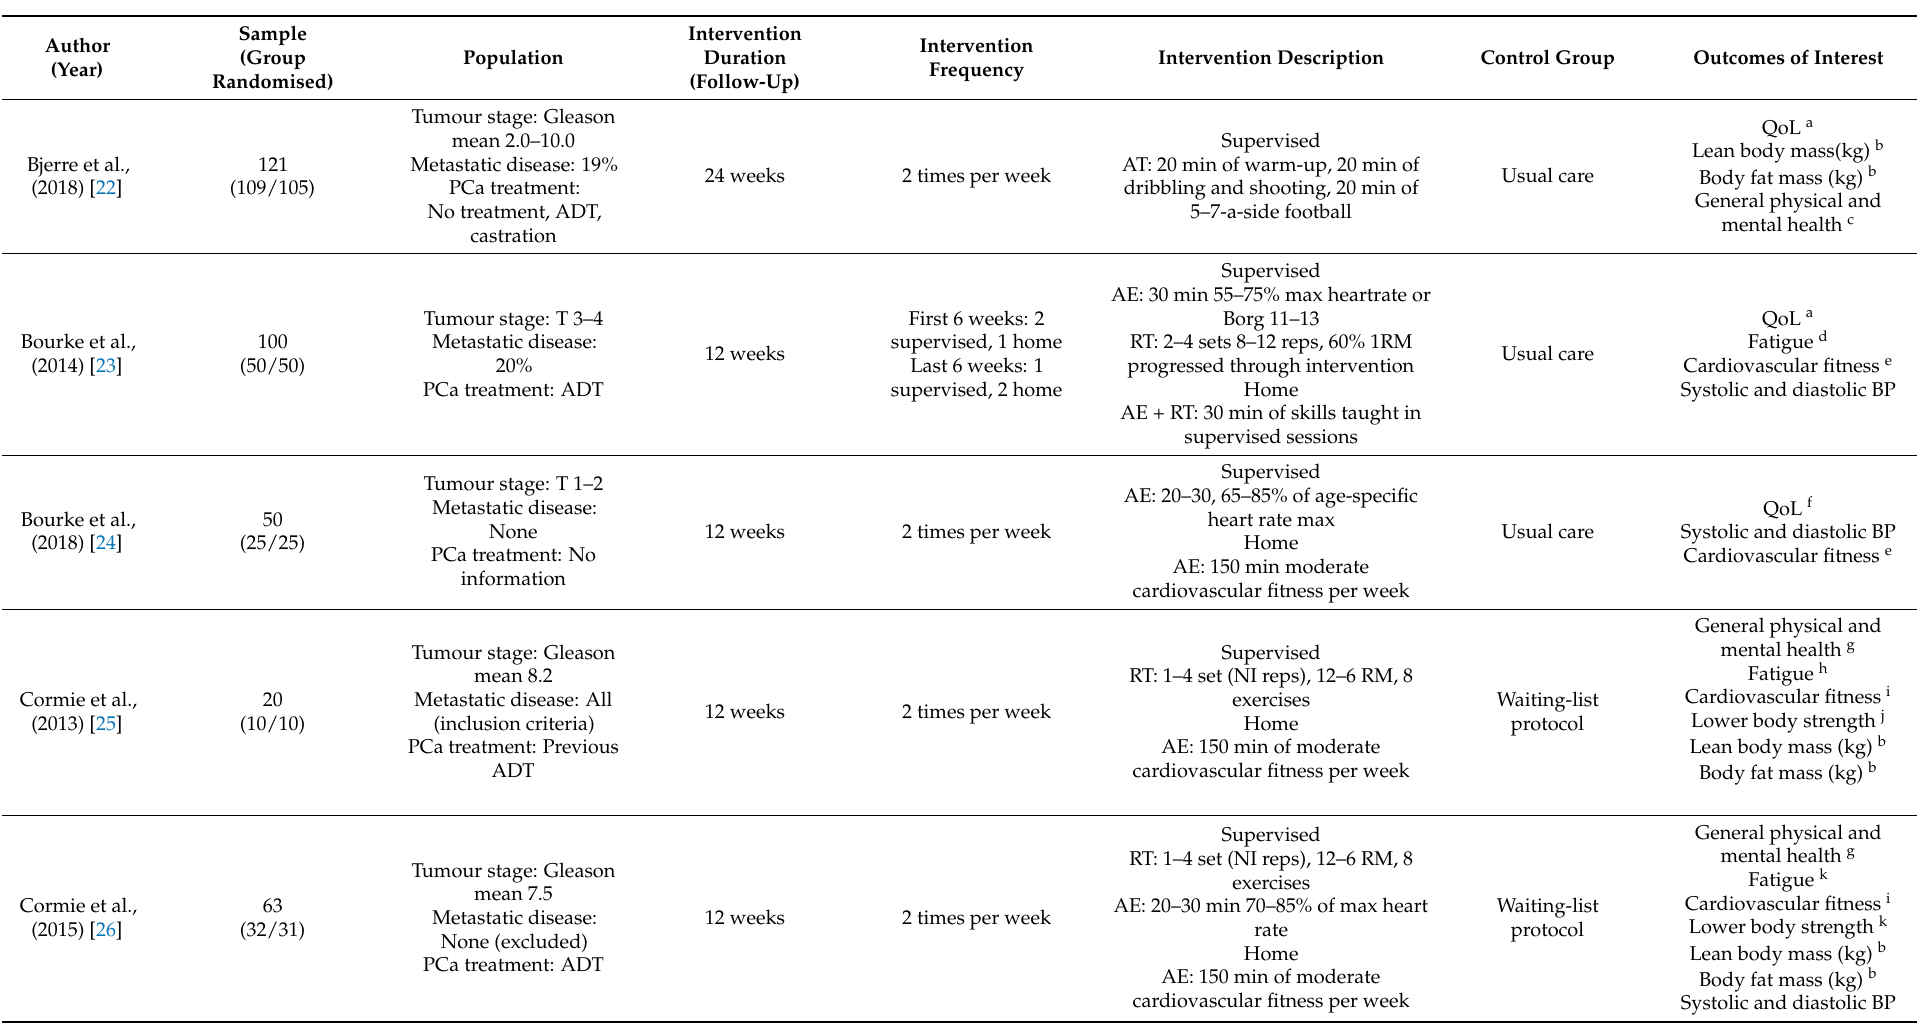
Table 1. Study characteristics in alphabetic